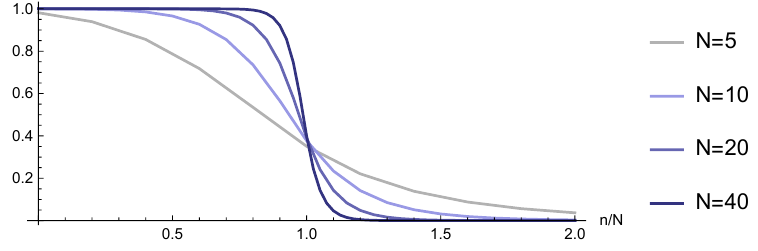
Figure 2 . The numerical values of Nc ( N ) as function of k , for di(cid:11)erent values of N . Here ~ is k chosen so that (cid:21) = N= ~ = 1. As N becomes large, the coe(cid:14)cients display the step behavior (2.23) typical of a Fermi gas at zero